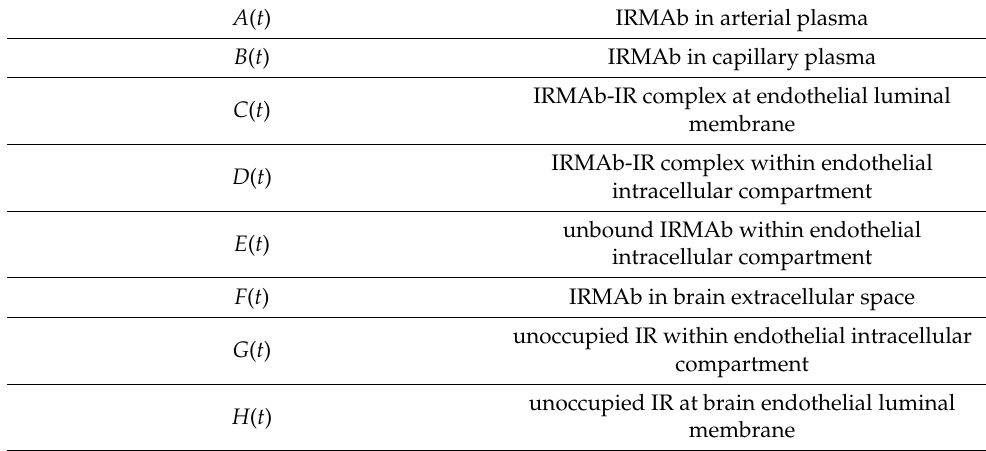
Figure 5. Insulin receptor (IR) model. Variables are defined in Table 6. Basal parameter values are given in Table 7. Table 6. Definitions of concentration variables for IR model.